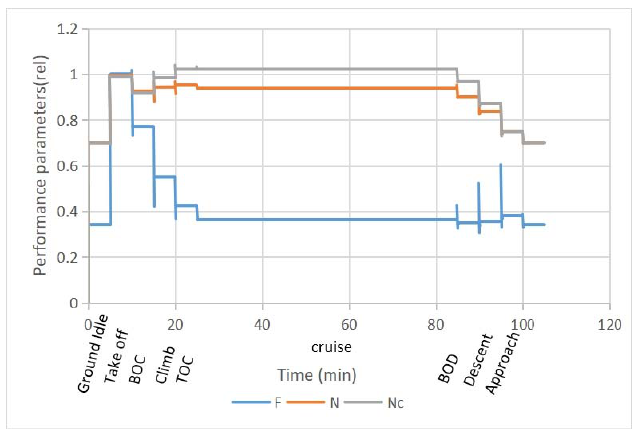
Figure 18. Simulation results of a flight mission.